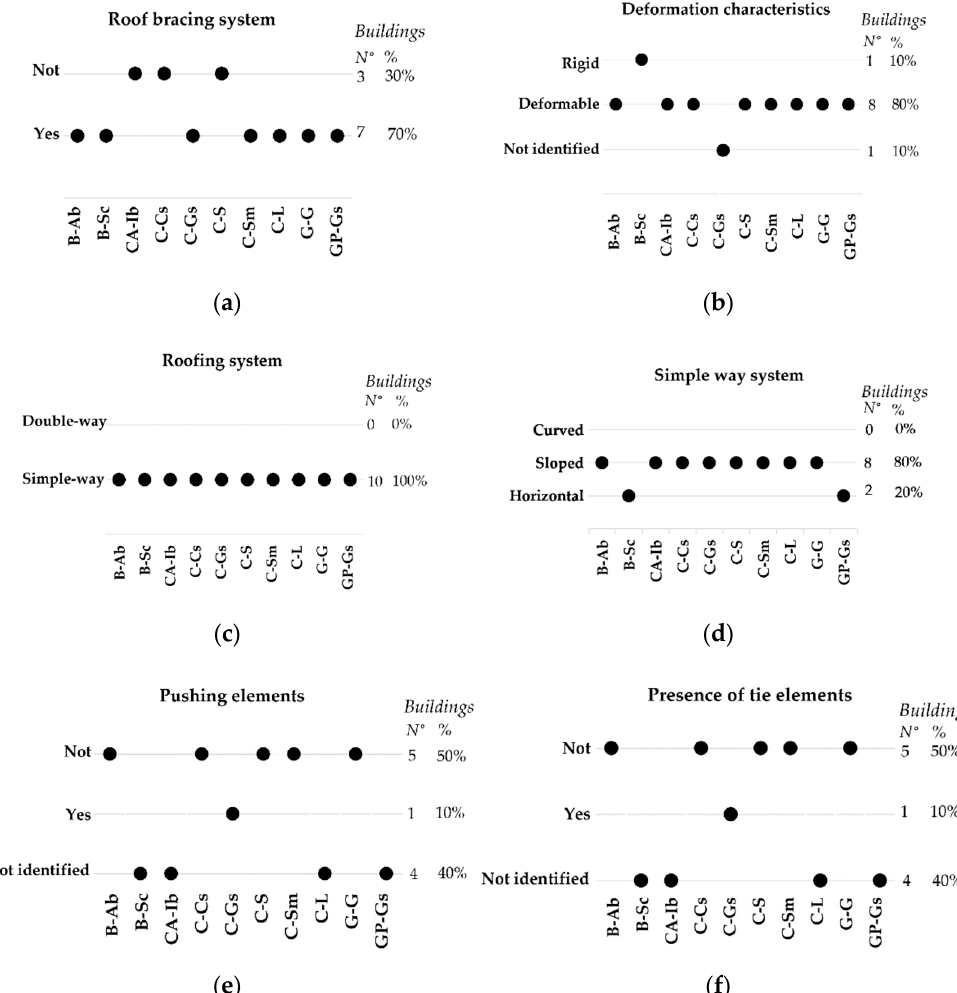
Figure 14. Section 1B CARTIS-Building. Roof: ( a ) Roof bracing system; ( b ) Deformation characteristics; ( c ) Roofing system; ( d ) Shape of the roof; ( e ) Pushing elements; ( f ) Presence of tie elements.